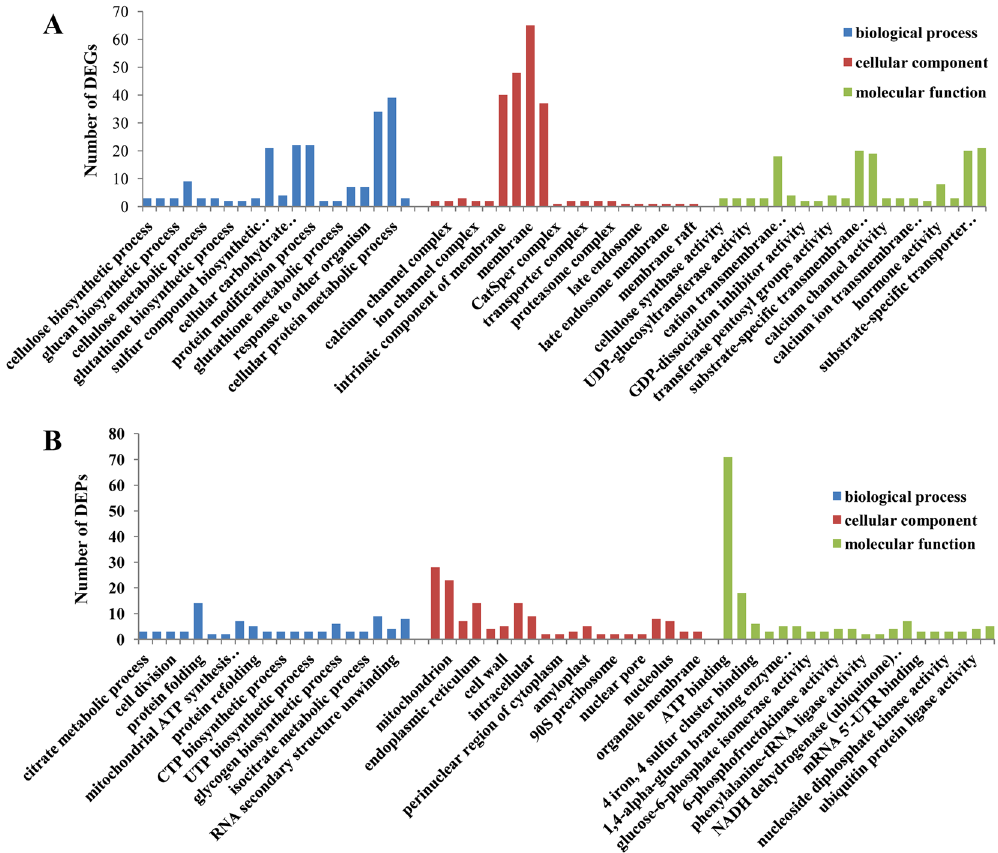
Figure 3. ( A ) GO categories for significantly differentially expressed genes in the transcriptome. ( B ) GO categories for significantly differentially abundant protein species in the proteome. Color panels highlight the three GO terms in this study, and the bar graph represents the unigene and protein number. plot generated using the ‘ggplot2’ packages in R 31,32